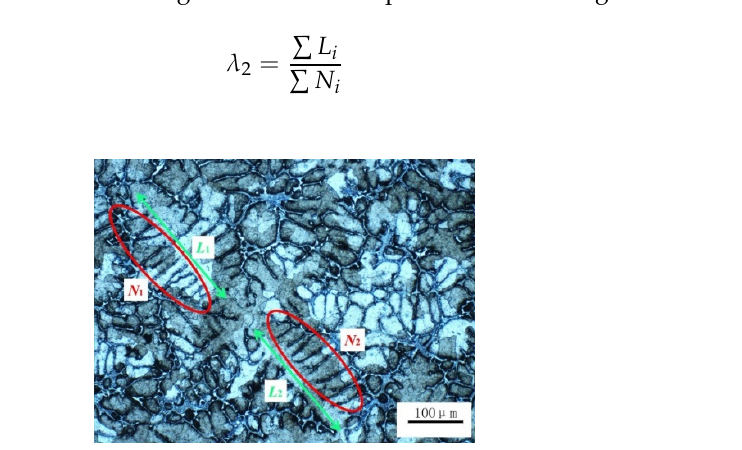
Figure 4. Measurement of the lengths of the dendrites (Li) and the number of secondary dendrite arms (Ni).